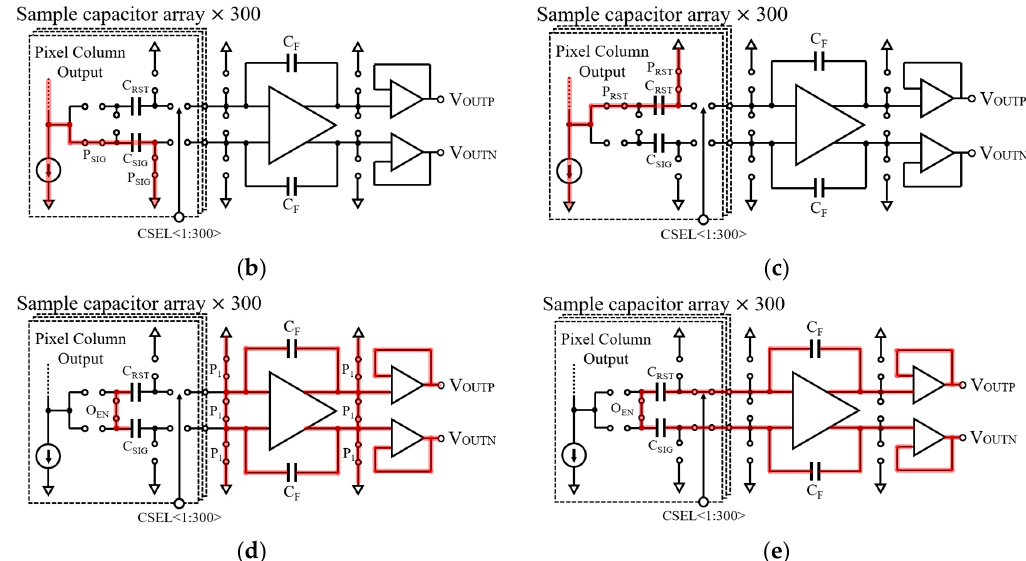
Figure 6. Readout circuit and timing diagram: ( a ) Overall readout circuit and timing diagram; ( b ) Signal sampling; ( c ) Reset value sampling; ( d ) Initializing the switched capacitor amplifier; ( e ) Differential output generation.